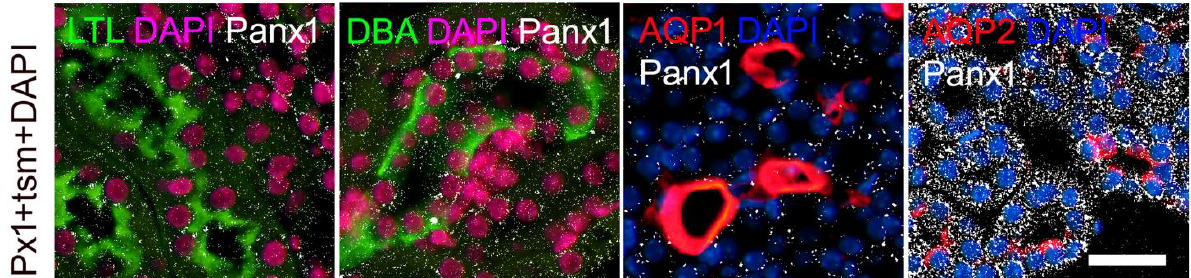
Figure 6. Colocalization of connexin 45 and Panx1 with different tubular segment markers in the mice kidney. Sections from the wild-type mice. Lotus tetragonolobus lectin (LTL), proximal tubule marker (green; first column); Dolichos biflorus agglutinin (DBA), distal tubule marker (green; second column); aquaporin 1 (AQP1), thin descending loop of Henle marker (red; third column); aquaporin 2 (AQP2), collecting duct marker (red; fourth column). Nuclei were stained with DAPI (blue in third and fourth column; magenta — pseudocolorized in first and second column); tsm — tubular segment marker. Scale-bar = 20 µm, refers to all (magnification 400×).